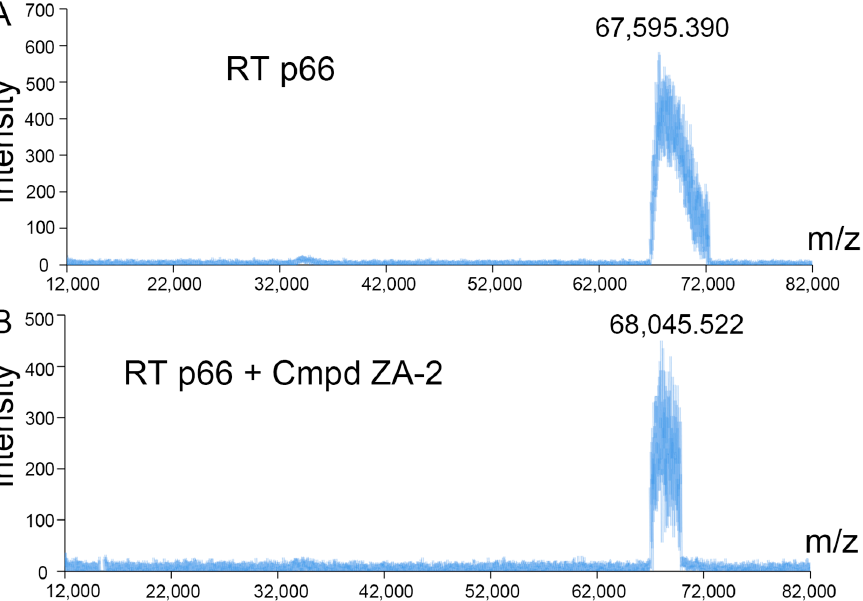
Figure 3. Representative spectra for MALDI-TOF MS analysis of RT covalent catalysis. ( A ) spectra for RT p66 protein; ( B ) spectra for RT p66 protein after incubation with ZA-2 .